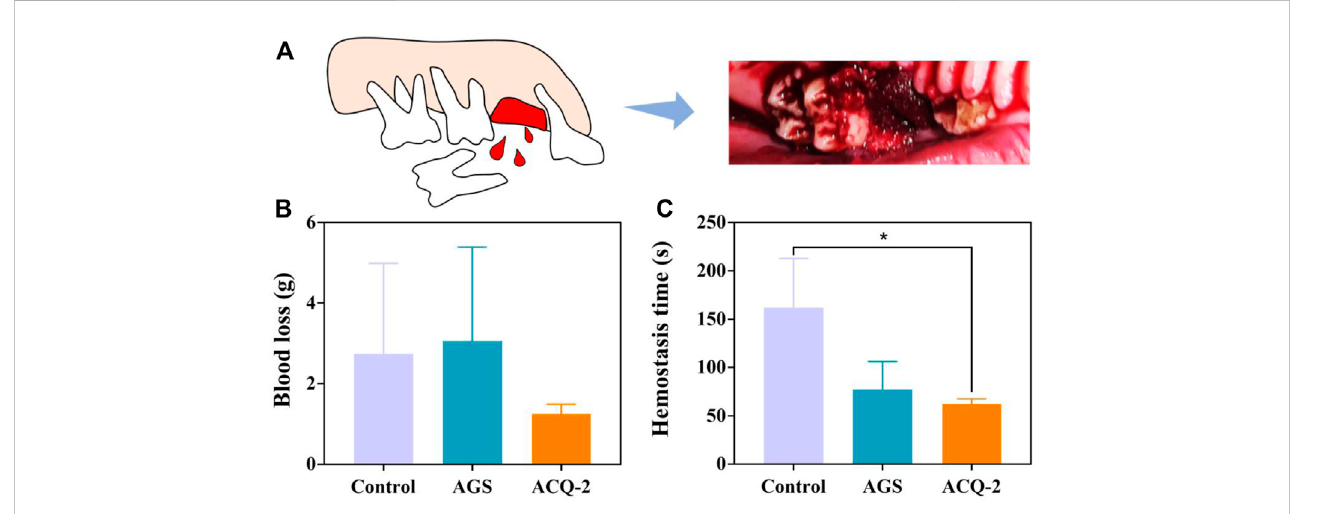
FIGURE 8 (A) Schematic diagram of pig tooth extraction. (B) Blood loss and (C) hemostasis time in tooth extraction hemostasis experiments. Data are mean ± SD (n = 3) (* p <